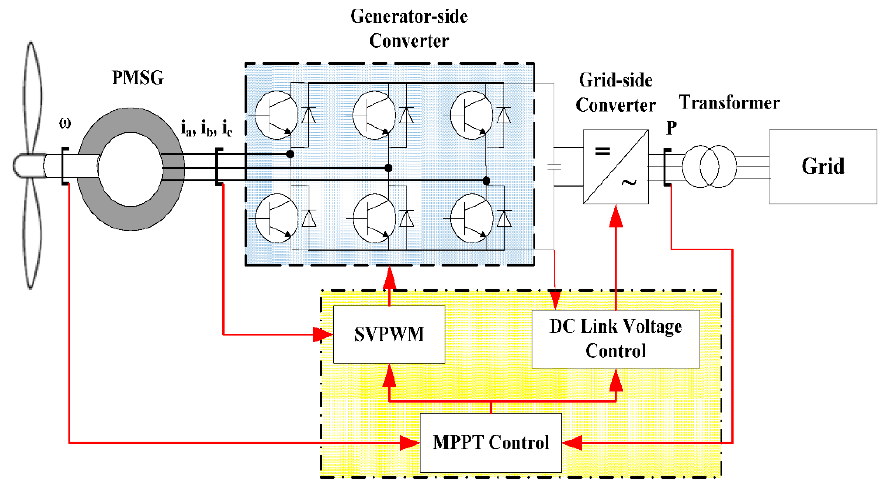
Figure 2. Typical diagram of wind-turbine system.